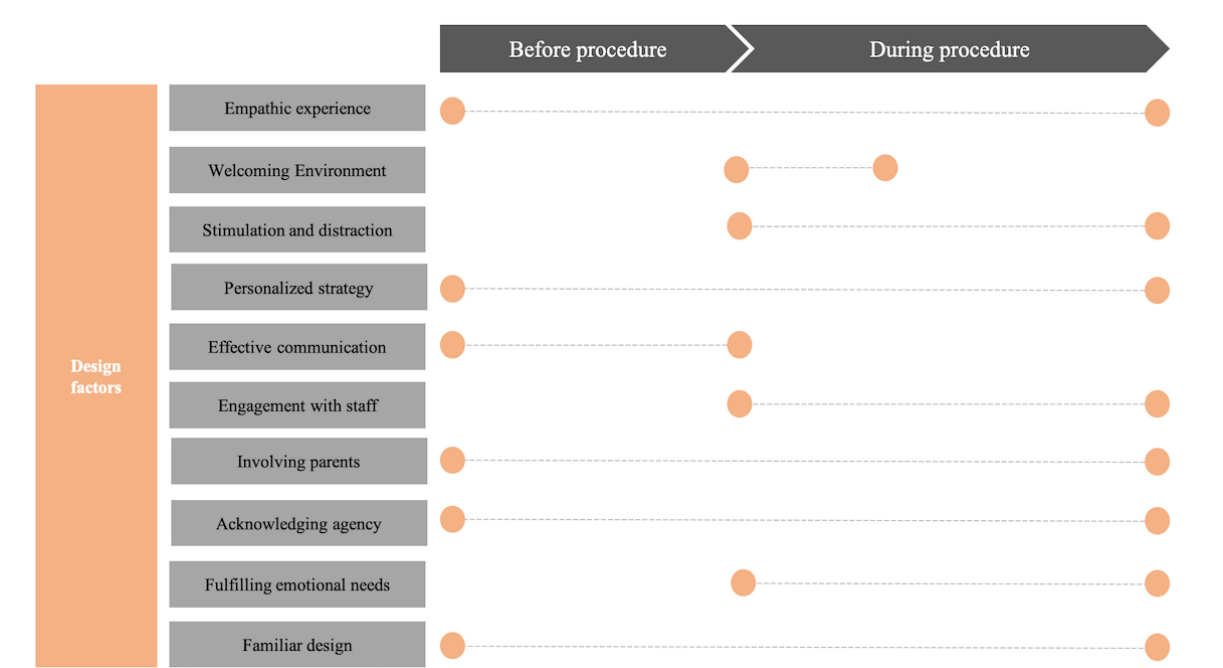
Figure 1. The patient journey mapped across the medical procedure phases (before and during) with design factors that can make an impact in either or both of those